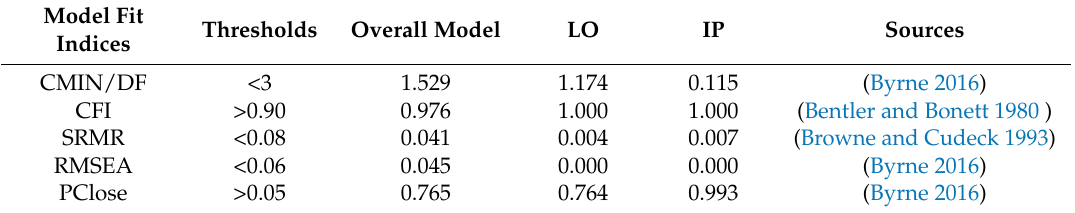
Table 4. Model fit indices in CFA.